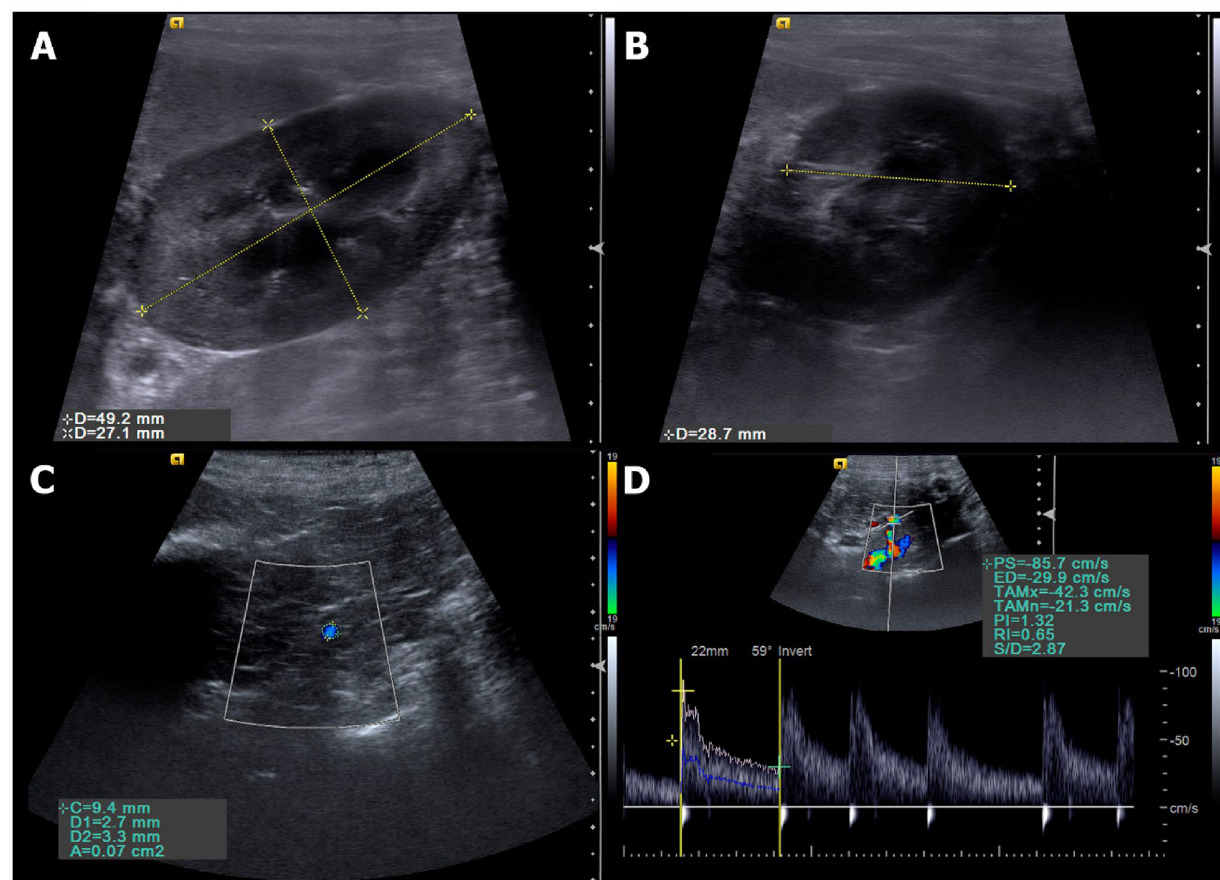
Figure 1. Ultrasonographic evaluations performed. ( A ) B mode sonographic sagittal view of the left kidney of a bitch delimited by the electronic callipers, measuring the length and height. ( B ) B mode sonographic transverse view of the left kidney of a bitch at the level of the renal hilum to measure the transverse height. ( C ) Color Doppler sonographic image of the renal artery (delimitated by the circle calliper) to obtain the vessel area. ( D ) Pulsed-wave Doppler of the renal artery to obtain the spectral tracing and Doppler flowmetry